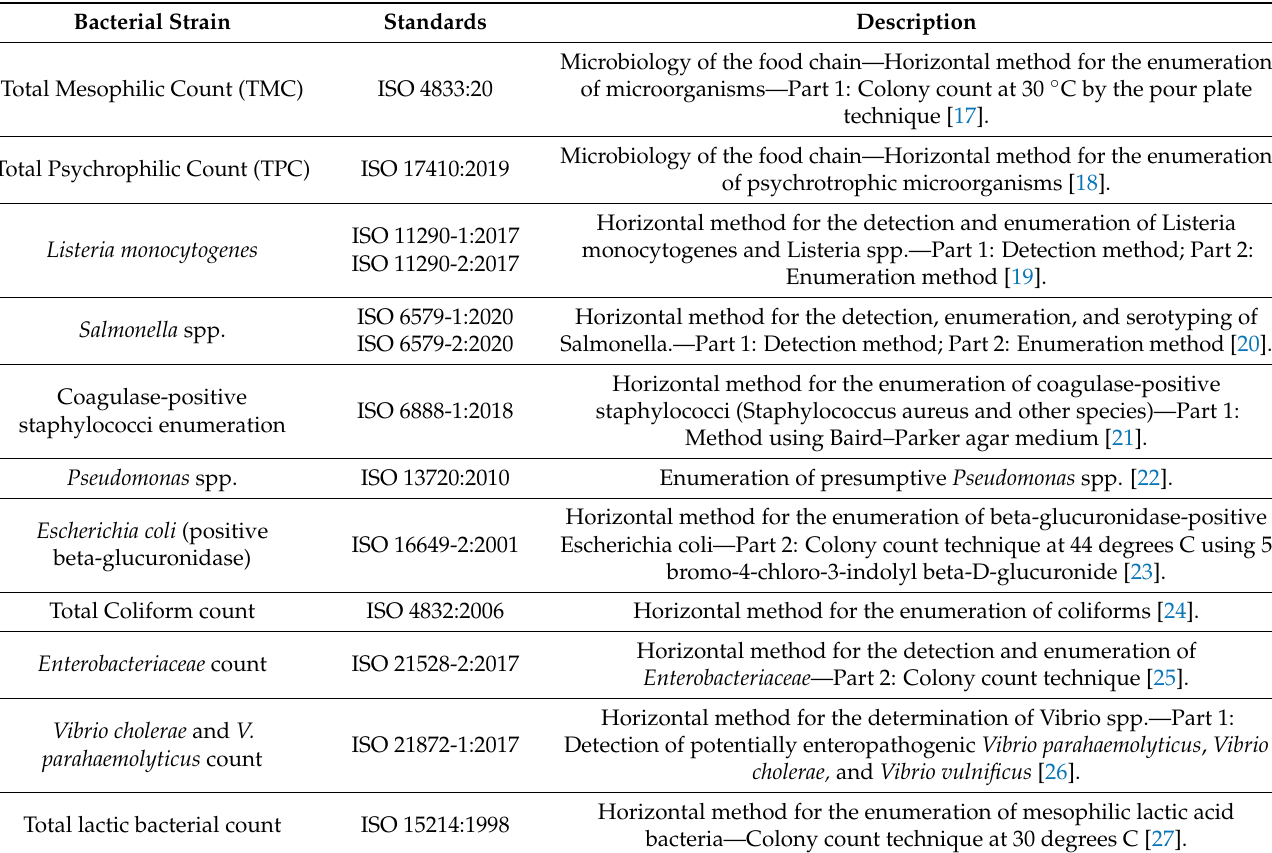
Table 3. Microbiological screenings performed in this study in accordance with specific UNI EN